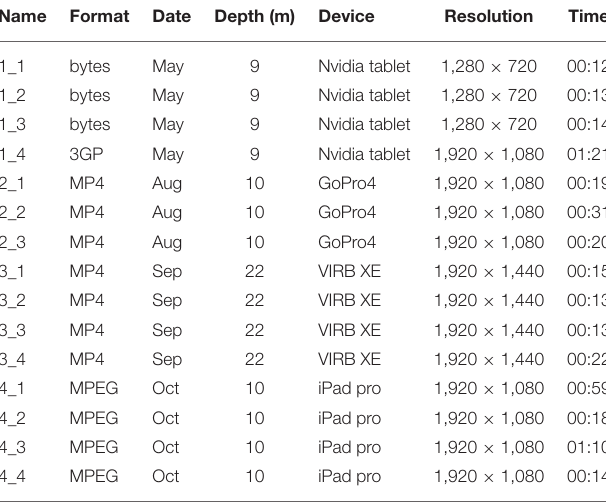
TABLE 1 | Summary of all videos used in